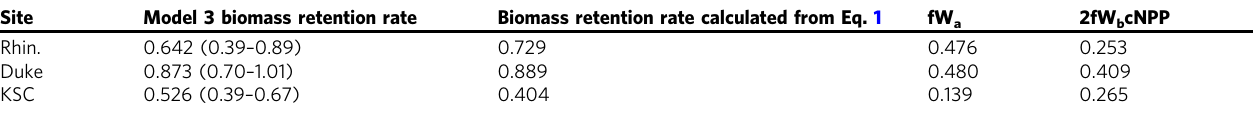
Table 3 Comparison of biomass retention rate (d Δ C veg /dcNPP) calculations Site